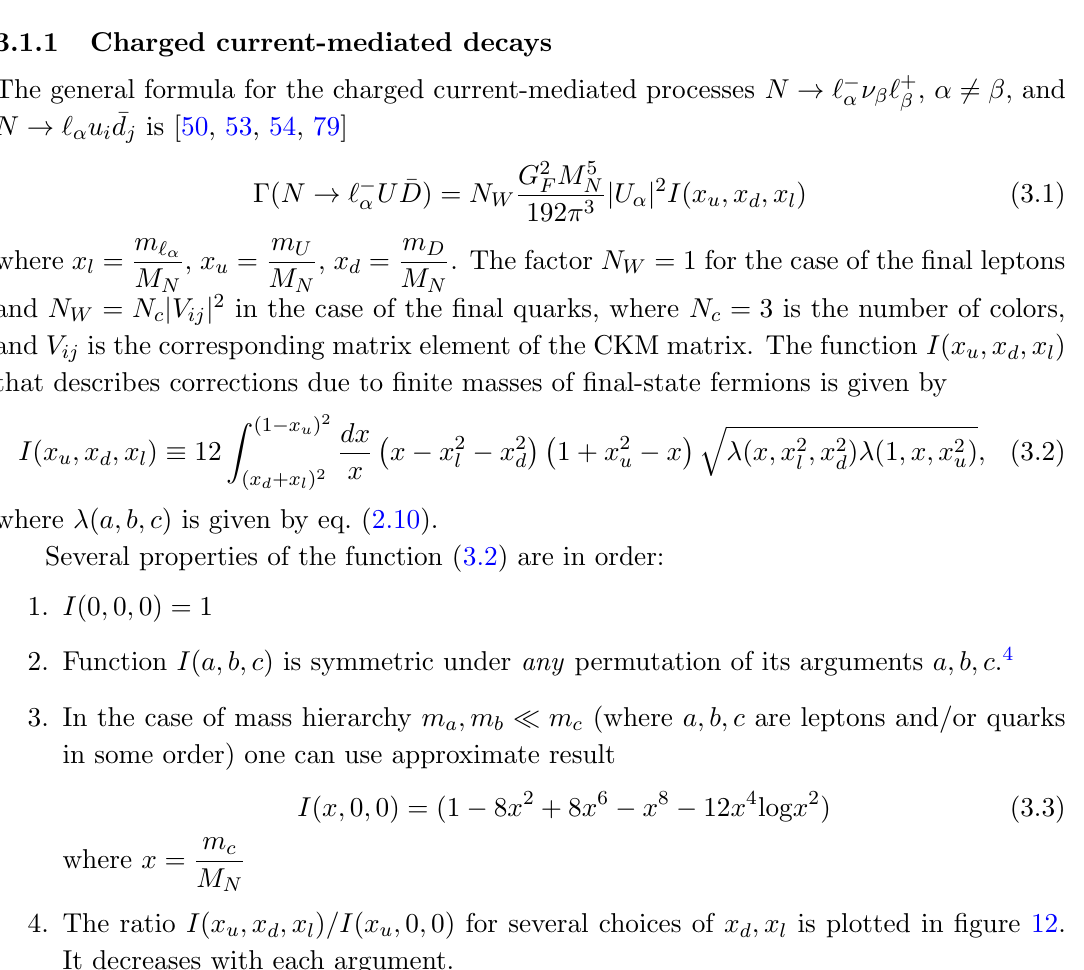
Figure 12 . Function I ( x u ; x d ; x l ) =I ( x u ; 0 ; 0) for several choices of x d and x l (see eq. (3.2) for I ( x u ; x d ; x l )